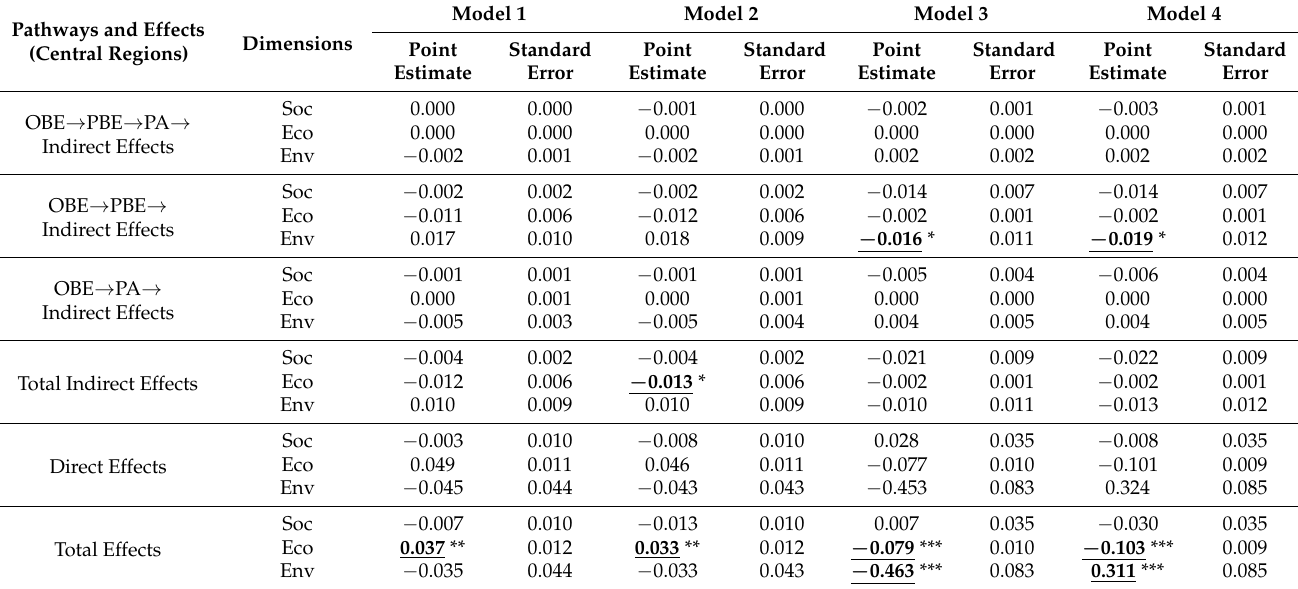
Table 7. Total, direct and indirect effects of OBE on P-RCR (central regions).